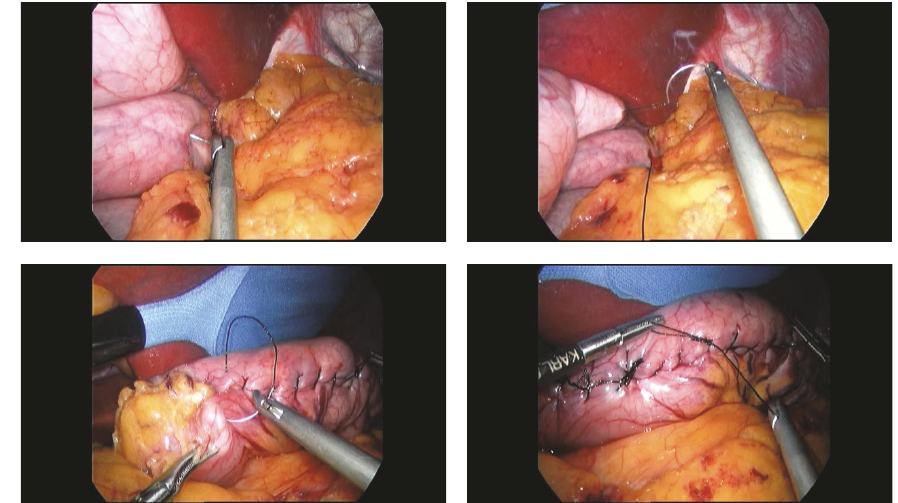
Figure 1: Gastric plication procedure. Suturing starts at the angle of